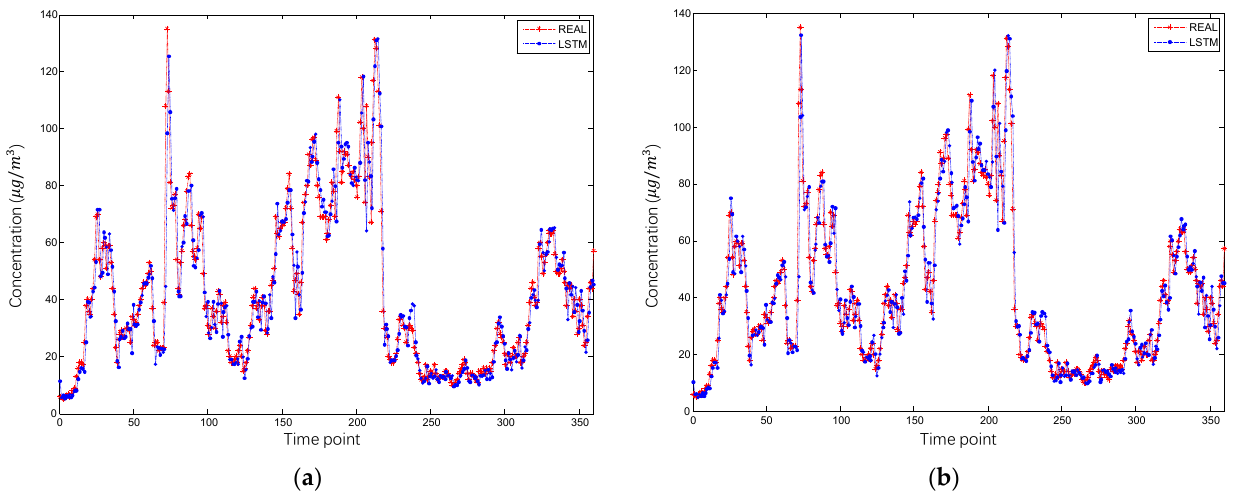
Figure 4. Prediction results of PM2.5 in different hidden layers of the LSTM model: ( a ) five hidden layers; ( b ) seven hidden layers.